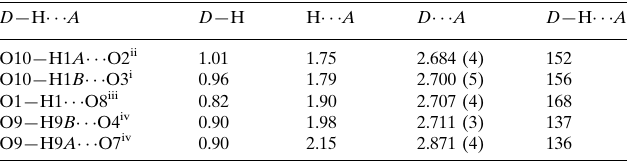
Hydrogen-bond geometry (A˚ , (cid:2)